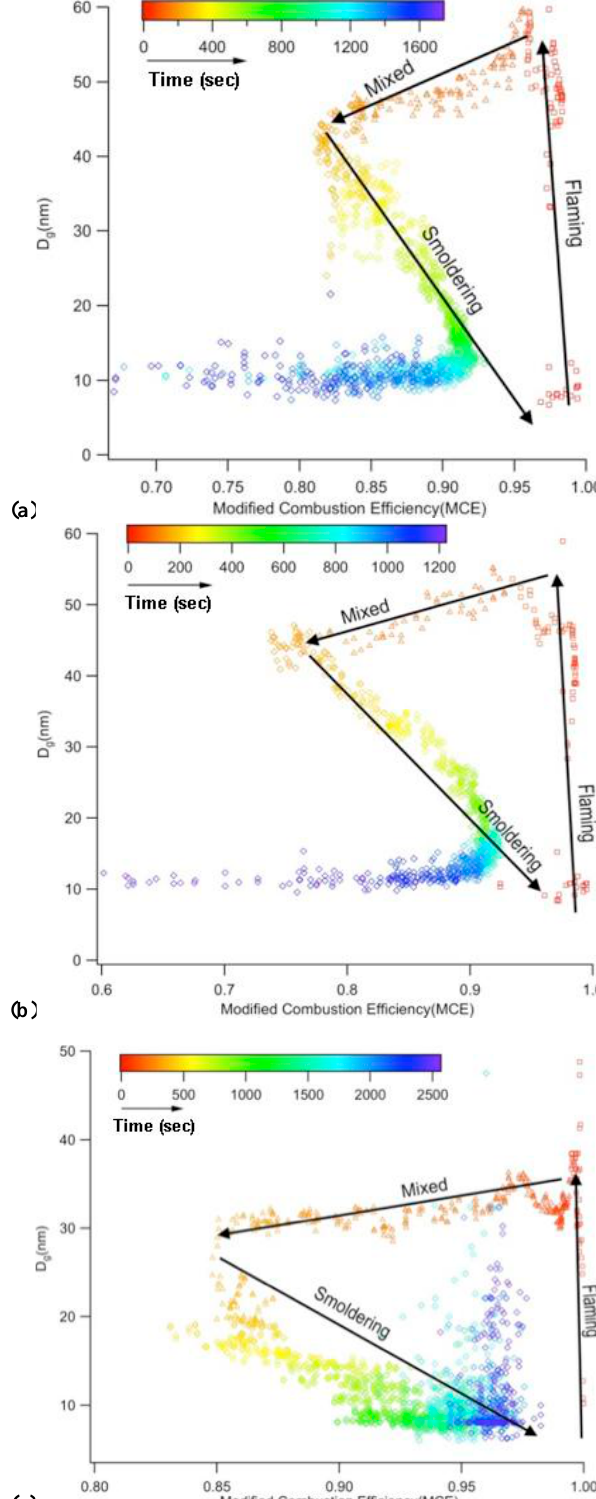
Fig. 9. MCE vs. Geometric Mean Diameter for three typical